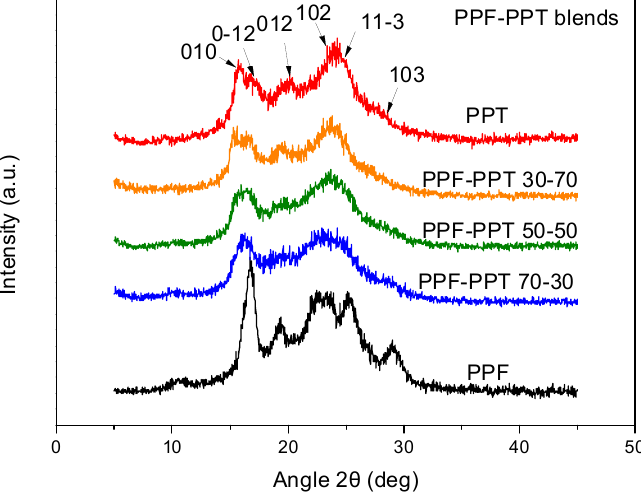
Figure 4. XRD patterns for neat poly(propylene terephthalate) (PPT), neat poly(propylene furanoate) (PPF), and their blends.